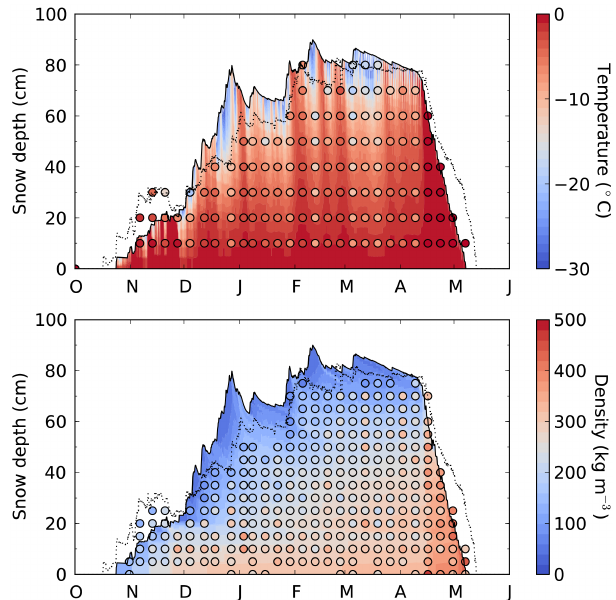
cus simulations (background colours) and snow pit measurements (coloured dots) for the winter of 2012–2013. Dotted lines show the measured snow depth.